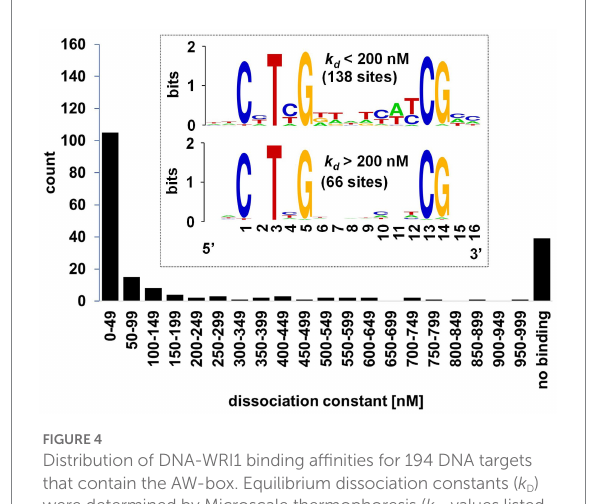
FIGURE 4 Distribution of DNA-WRI1 binding affinities for 194 DNA targets that contain the AW-box. Equilibrium dissociation constants ( k D ) were determined by Microscale thermophoresis ( k D -values listed in Supplementary Table 4). Inset: Sequence logos of 204 AW-box sites from the measured DNA fragments, separated according to ranges of k D values. “no binding”: DNA targets classified as non- binding based on binding curve (Supplementary Figure 4). Sequence logos were generated with WebLogo (Crooks et al.,